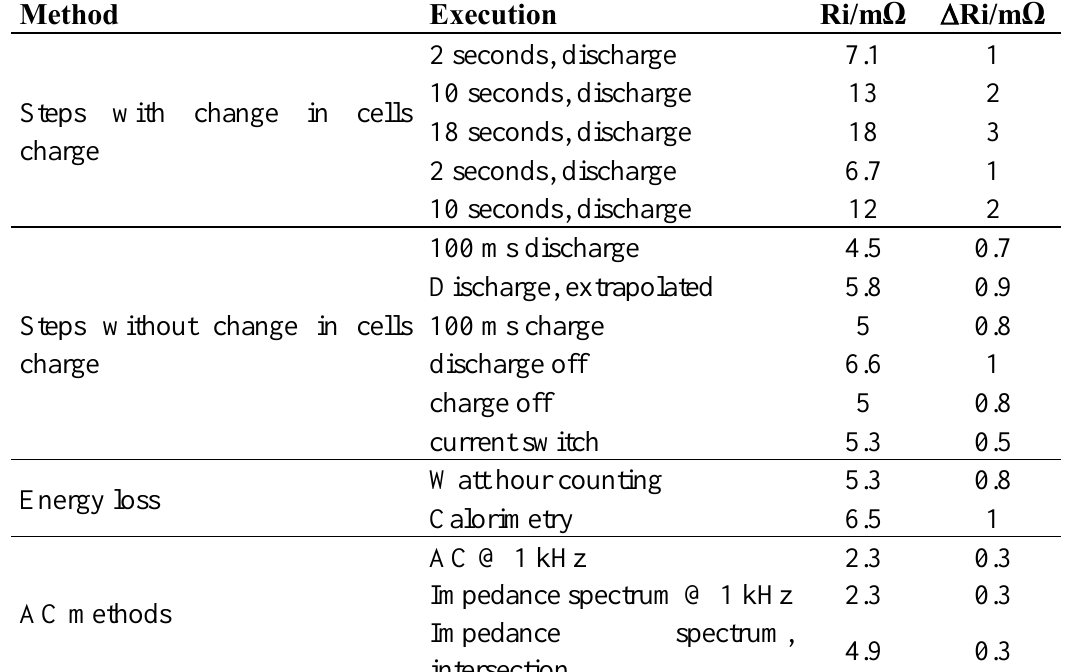
Table 2. Comparison of the outcome of internal resistance measurement with